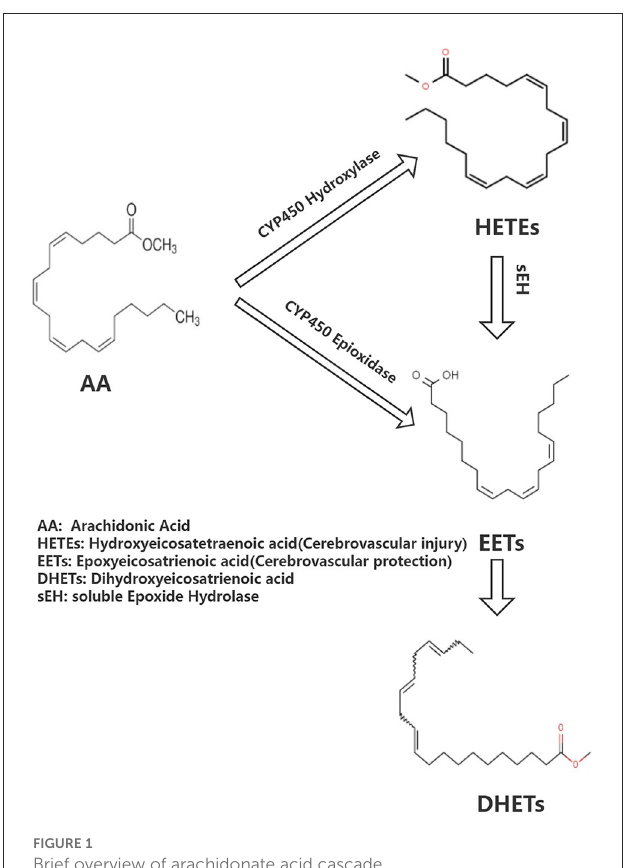
FIGURE1 Brief overview of arachidonate acid cascade.